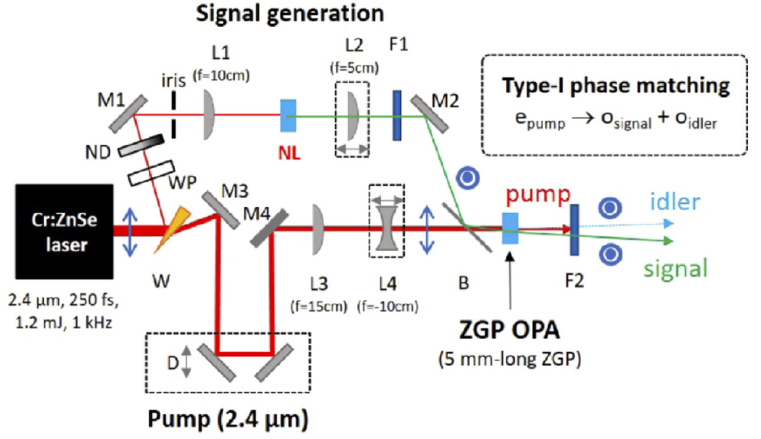
Figure 3. Experimental setup of MIR ZGP OPA. Red lines, 2.4 μ m pump beam; green line, signal (seed) beam; blue dotted line, idler beam. M1–M4: Al mirrors; L1–L4: CaF 2 lenses; F1: 3 μ m LPF; F2: